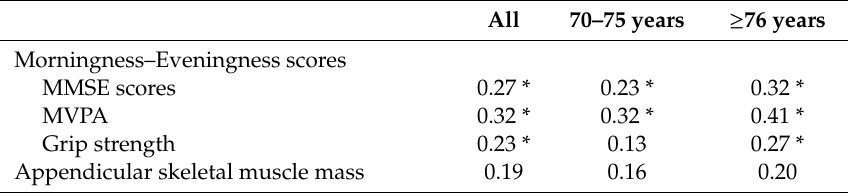
Table 2. Partial (parametric and non-parametric) correlation coe ffi cients (r) between Morningness– Eveningness scores, daily physical activity, Mini-Mental State Examination (MMSE) scores, and physical health.